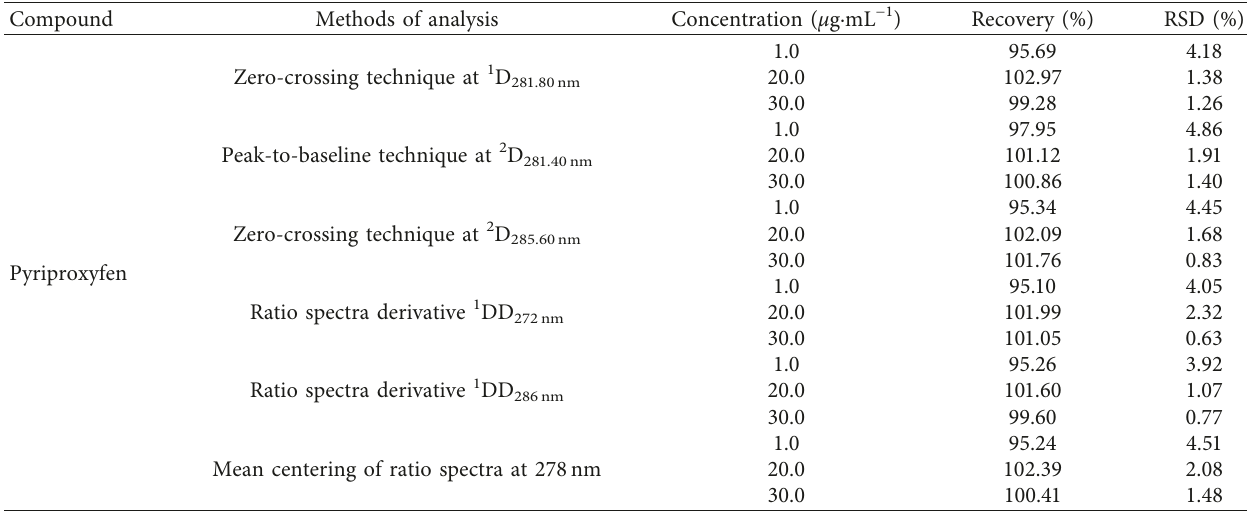
Table 2: The accuracy of the proposed methods for simultaneous determination of pyriproxyfen and chlorothalonil in a binary mixture.